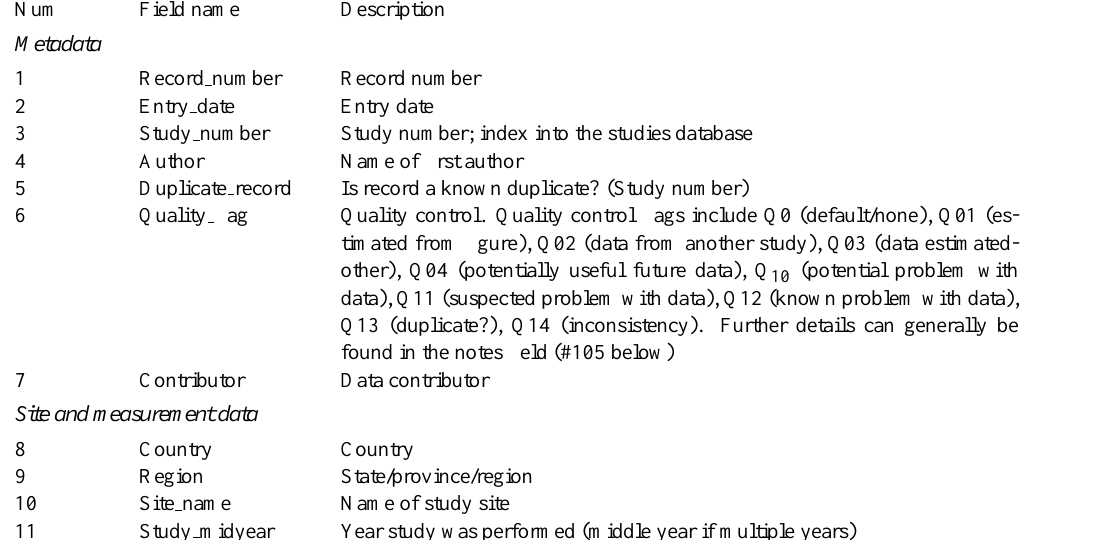
Table 1. Categories of database fields and examples of data included for the soil respiration ( R S ) database’s main “data” file. A separate “studies” file contains bibliographic information for all studies, indexed by a study number common to both